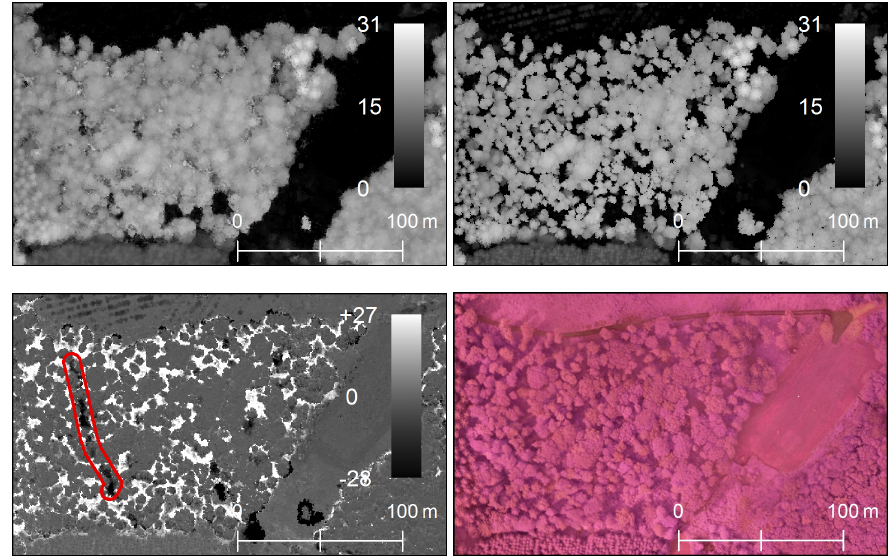
Figure 6. Evaluation of the differences between LiDAR and photo canopy height models: enlargement of a small part of the Felenne forest for visual comparison (units are in meters). ( Top Left ) photo-canopy height model (CHM); ( Top Right ) LiDAR-CHM; (Bottom Left ) difference in elevation between photo-CHM and LiDAR-CHM; ( Bottom Right ) false color ortho-photo